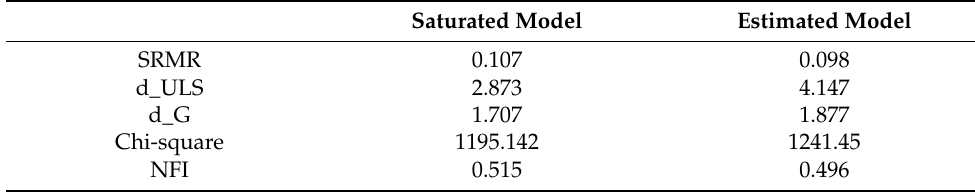
Table 3. Model Fit Summary.